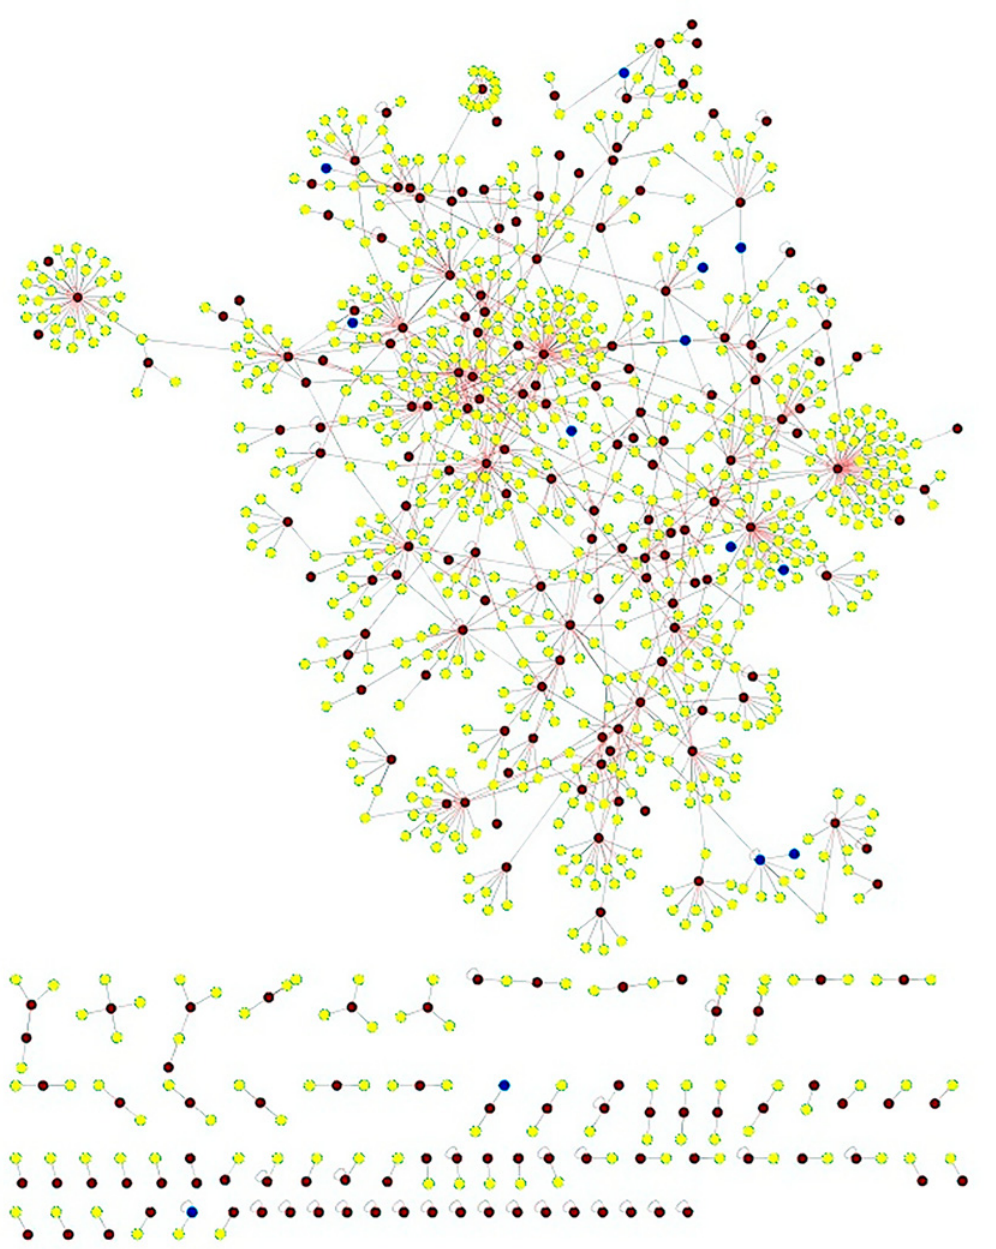
Fig 2. Psoriasis diseaseome along with proteins common in AD. Yellow nodes — proteins involved in psoriasis, red nodes — common proteins shared by AD and psoriasis and blue nodes — indirect interactions.